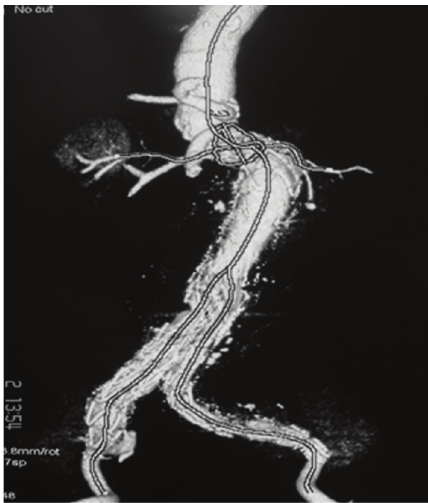
Figure 5: No endoleak was detected on CT angiography nine months postoperatively. The left limb of the graft is occluded, and the femorofemoral crossover bypass is patent.